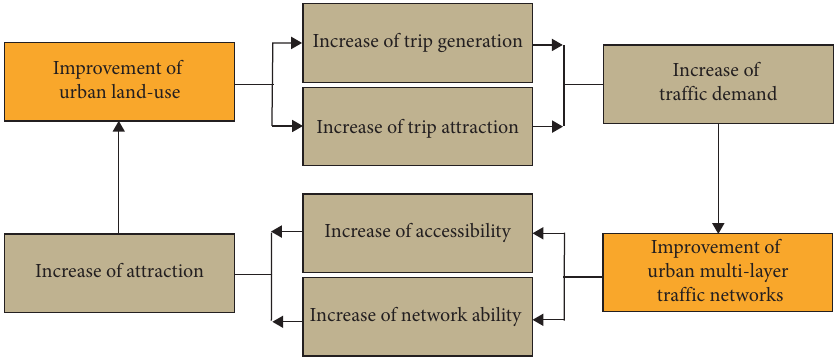
Figure 3: The simple coevolution relationships between traffic multilayer network and urban